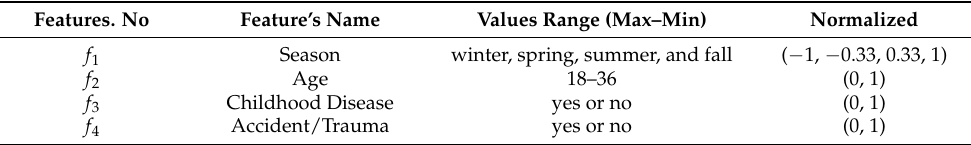
Table 1. Experimental Dataset